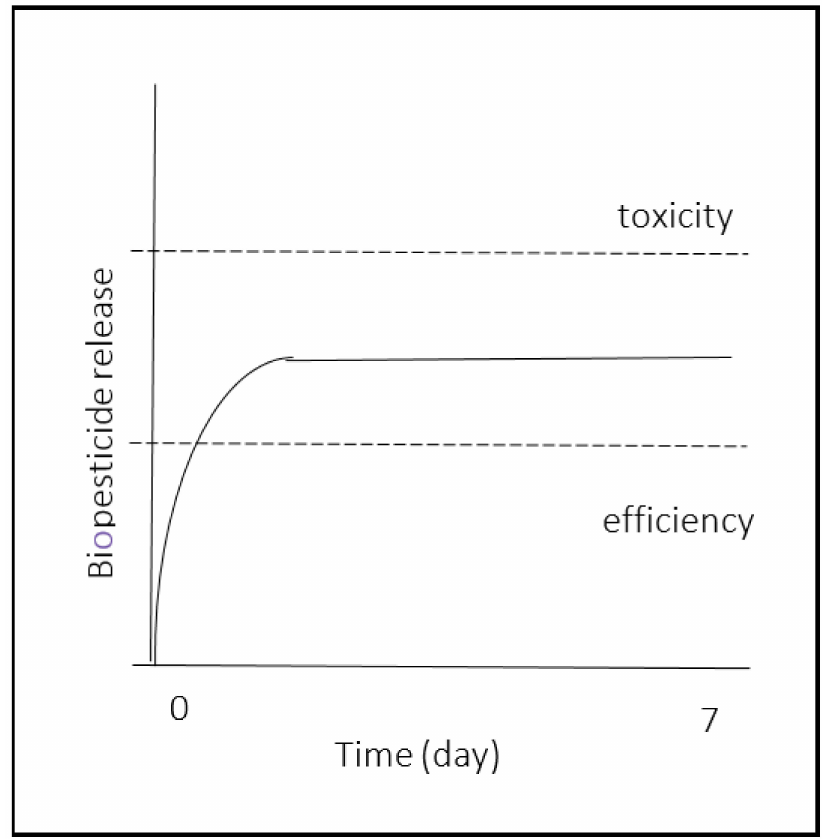
Figure 1. Controlled release of biopesticide outline showing an initial rapid release at the middle concentration between the active agent’s e ffi ciency and toxicity scale, followed by a long and constant